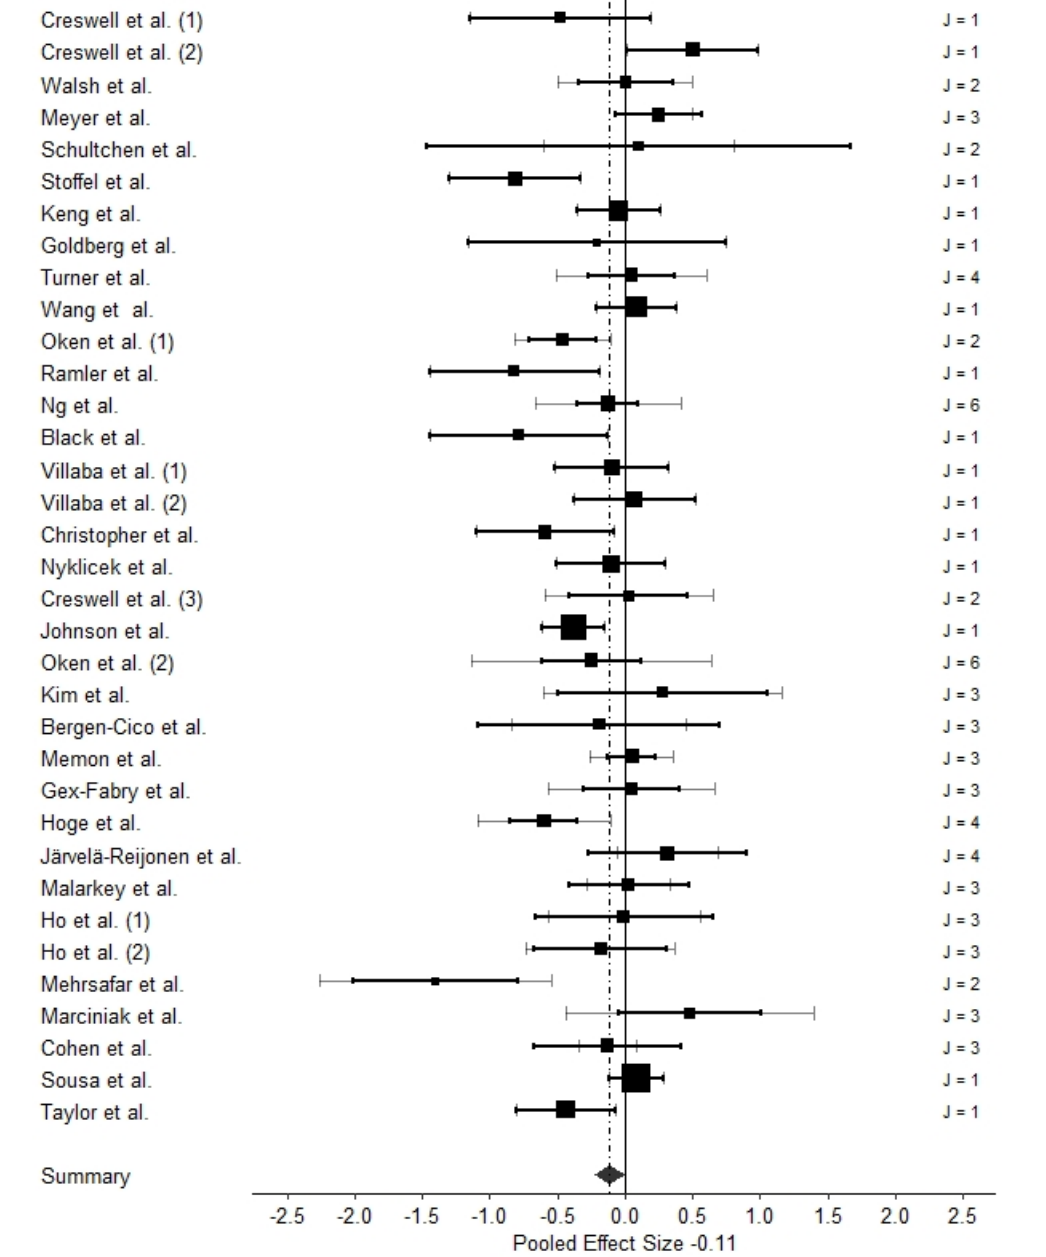
Table 3). Heterogeneity and total variance, not attributable to sampling error, were larger for Level 2 than Level 3; i.e., more variation was attributable to differences within studies (biomarkers) than between